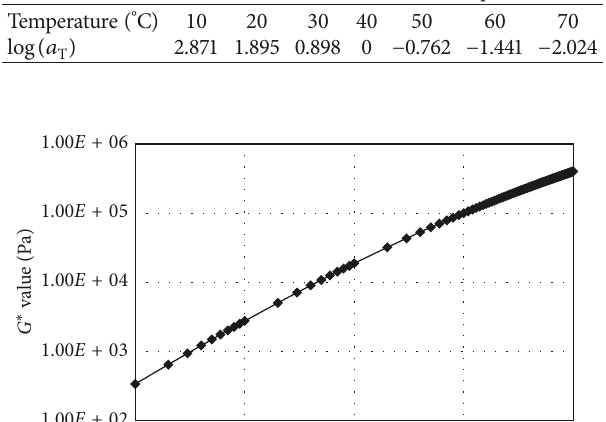
value master curve for the two mastics (VR ∗